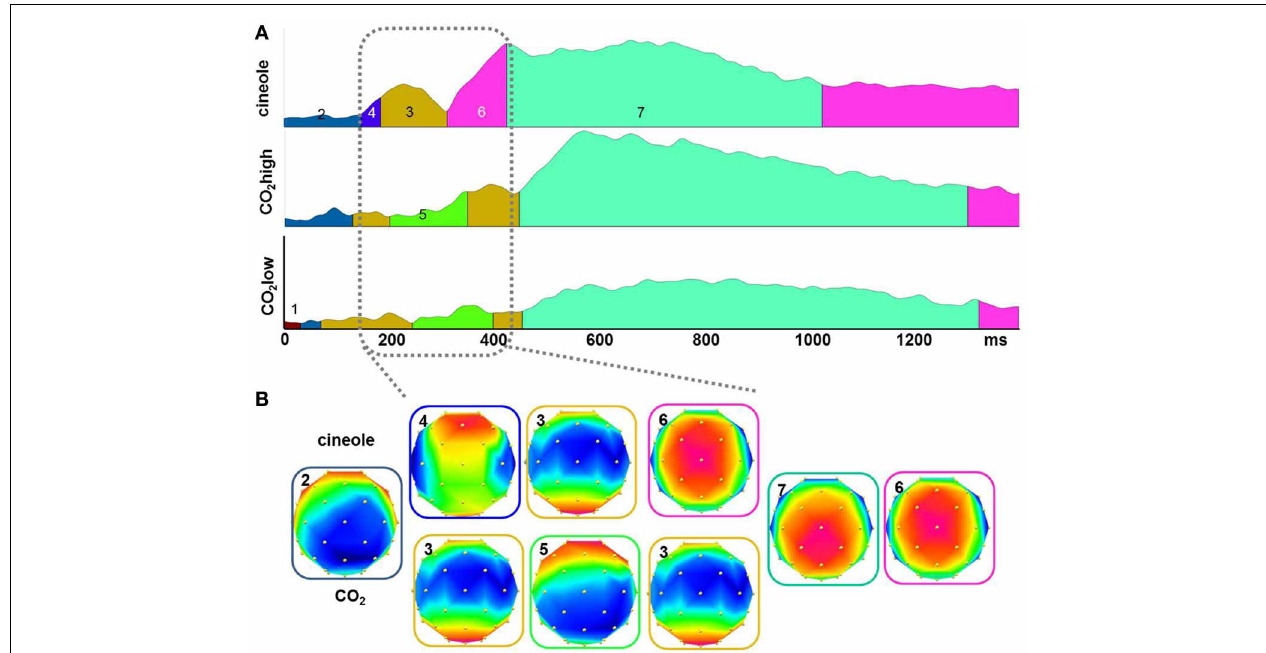
FIGURE 4 | The global field power (GFP) from all participants for the three stimulants were segmented into quasi-stable microstates using a topographic cluster analysis (A). Different microstates are indicated by different colors under the curve.